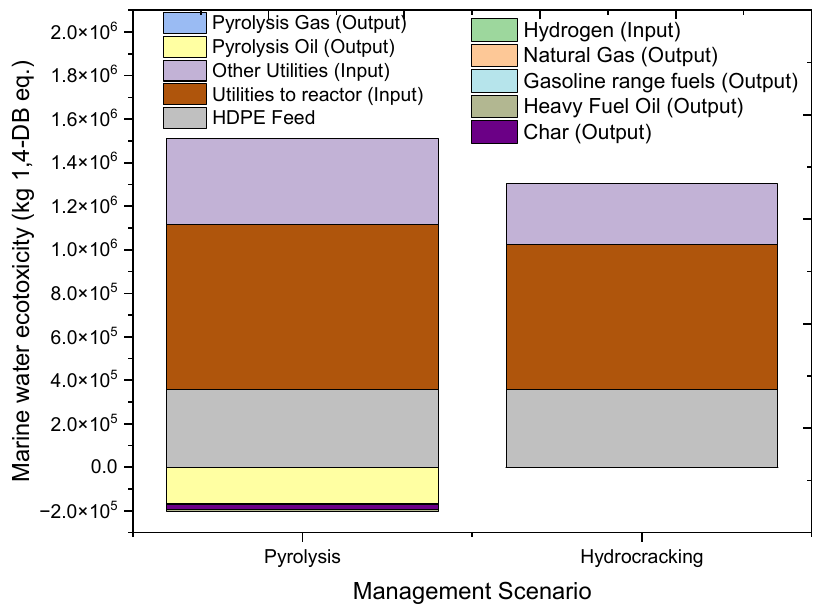
Figure 13. Impact assessment of pyrolysis and hydrocracking for the management of waste HDPE on marine aquatic ecotoxicity (kg 1,4-DB eq.).